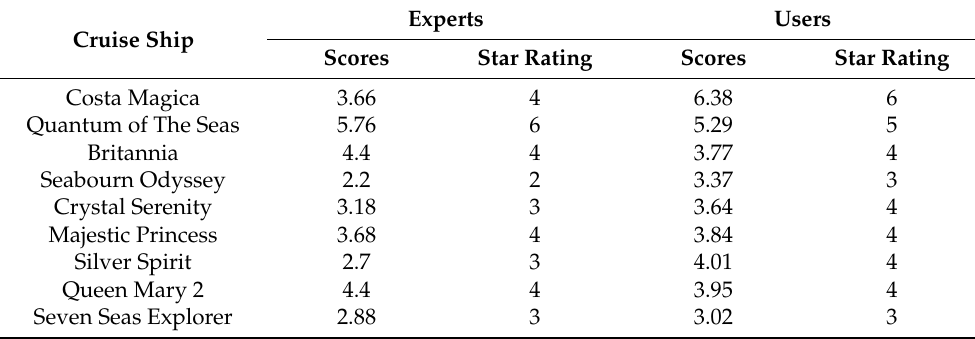
Table 10. Scores and staring rating results of nine cruise ships from experts and users.